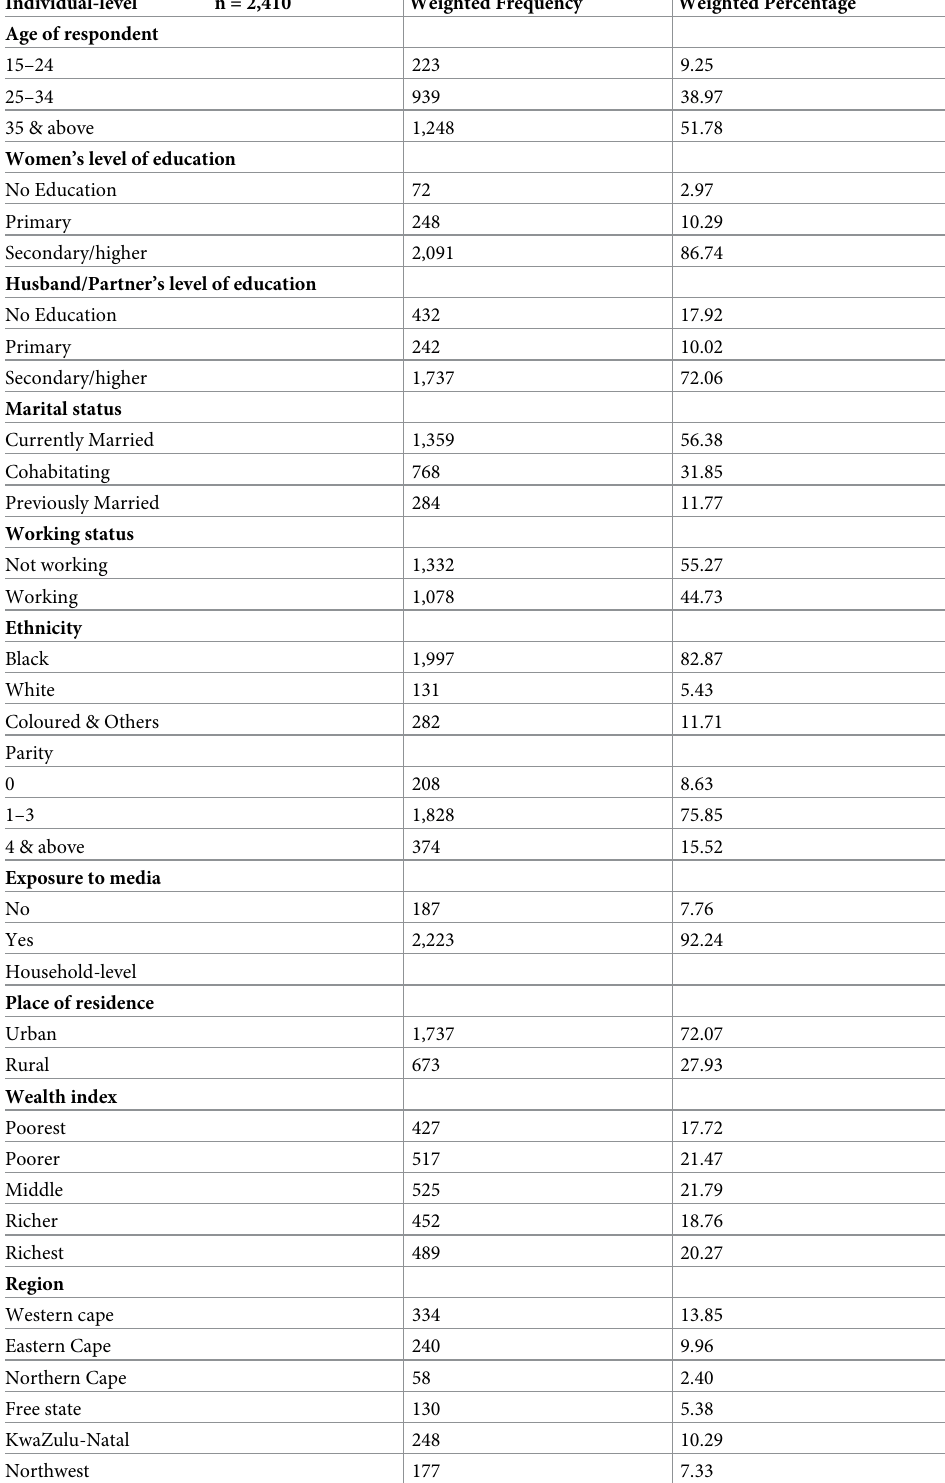
Table 1. Individual & household-level characteristics of